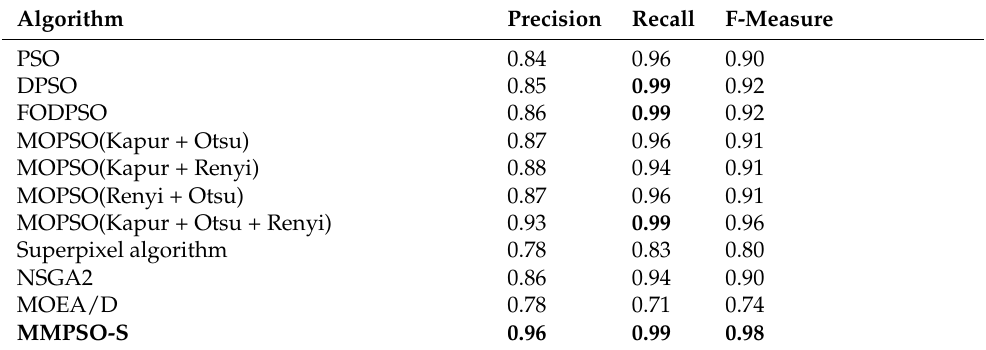
Table 7. Detection results of LD